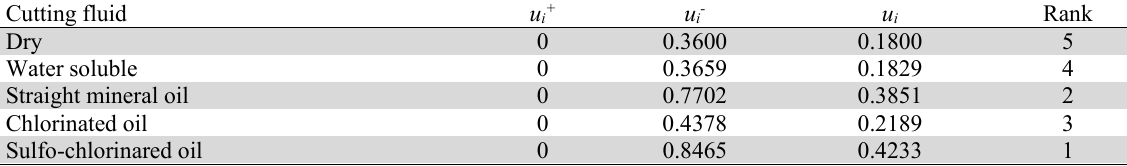
Computational details of the ROV method for case study 3 Cutting fluid u